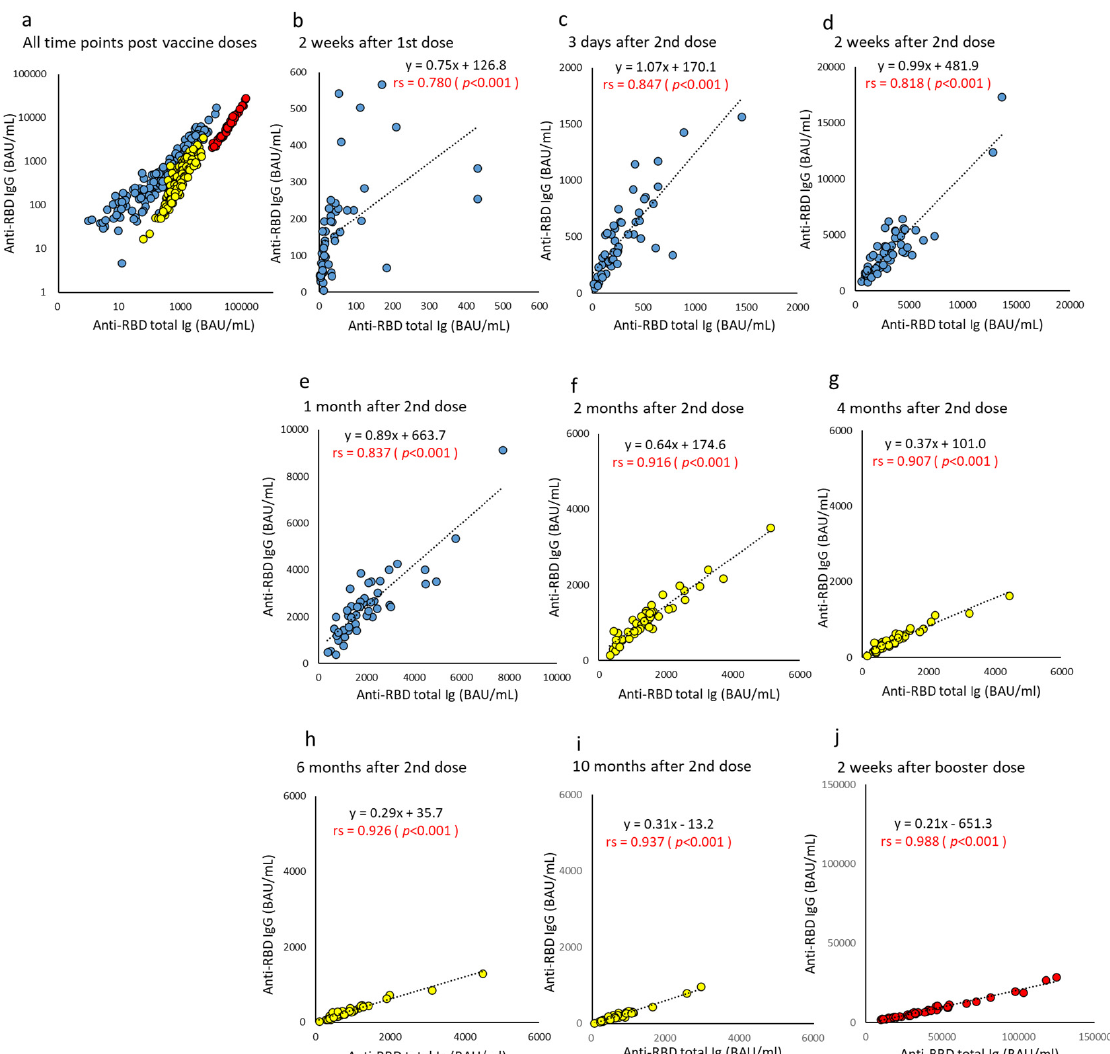
Figure 5. ( a – j ). Correlation at time points between anti-RBD total Ig and IgG after BNT162b2 vaccine doses. The levels of parameters indicating anti-RBD total Ig and IgG of humoral immunity are plotted, and the correlation is compared using all or each time point post-vaccine doses. Antibody titers at all time points are indicated on a log scale ( a ). Time points until one month after two doses are represented by blue ( b – e ), from two months to 10 months after two doses are represented by yellow ( f – i ), and two weeks after the booster dose are represented by red ( j ). p -values were calculated using Spearman’s rank correlation test, and significance was set at 0.01. Red values indicate a significant correlation (rs, Spearman’s rank correlation